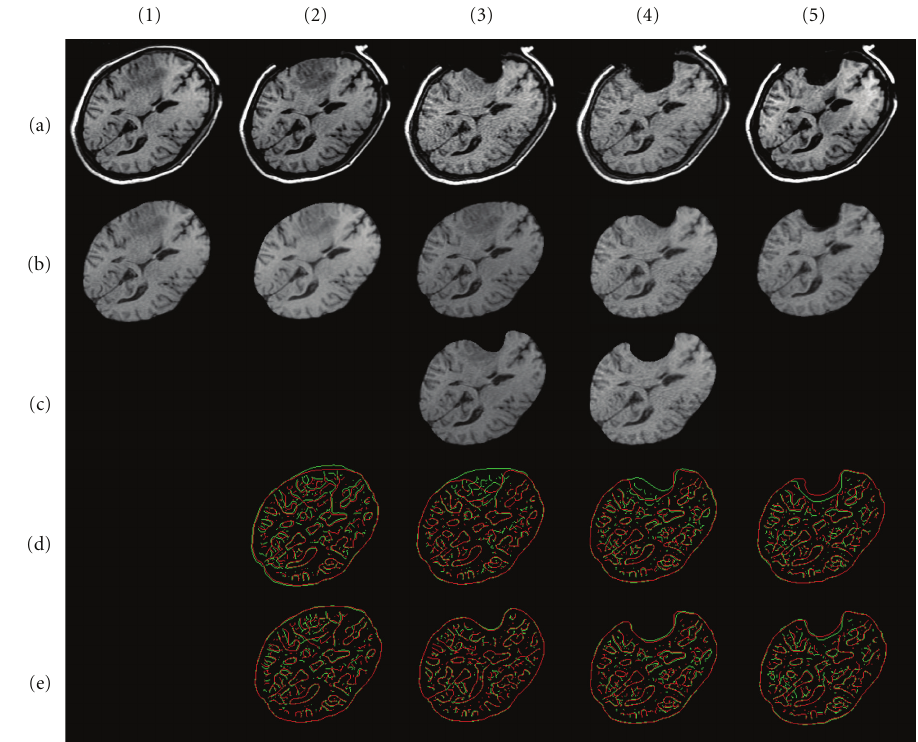
Figure 5: First patient case. (a) Sequence of five input iMR images rigidly registered to the first one. (1b) Whole-brain region extracted from (1a). (2b) Deformation of (1b) computed using FEM for brain shift modeling. (3b) Deformation of whole-brain region extracted from (2a) computed using FEM for 1st resection modeling. (3c) Masking of (3b) with whole-brain region segmented from the 3rd iMR image (3a). (4b) Deformation of whole-brain region extracted from (3a) computed using XFEM for 2nd resection modeling. (4c) Masking of (4b) with whole-brain region segmented from 4th iMR image (4a). (5b) Deformation of whole-brain region extracted from (4a) computed using FEM for 3rd resection modeling. (d) Juxtaposition of Canny edges of images rigidly registered. The edges of the first (second) image of the pair under consideration are in green (red). (e) Ditto for (d) when images are nonrigidly